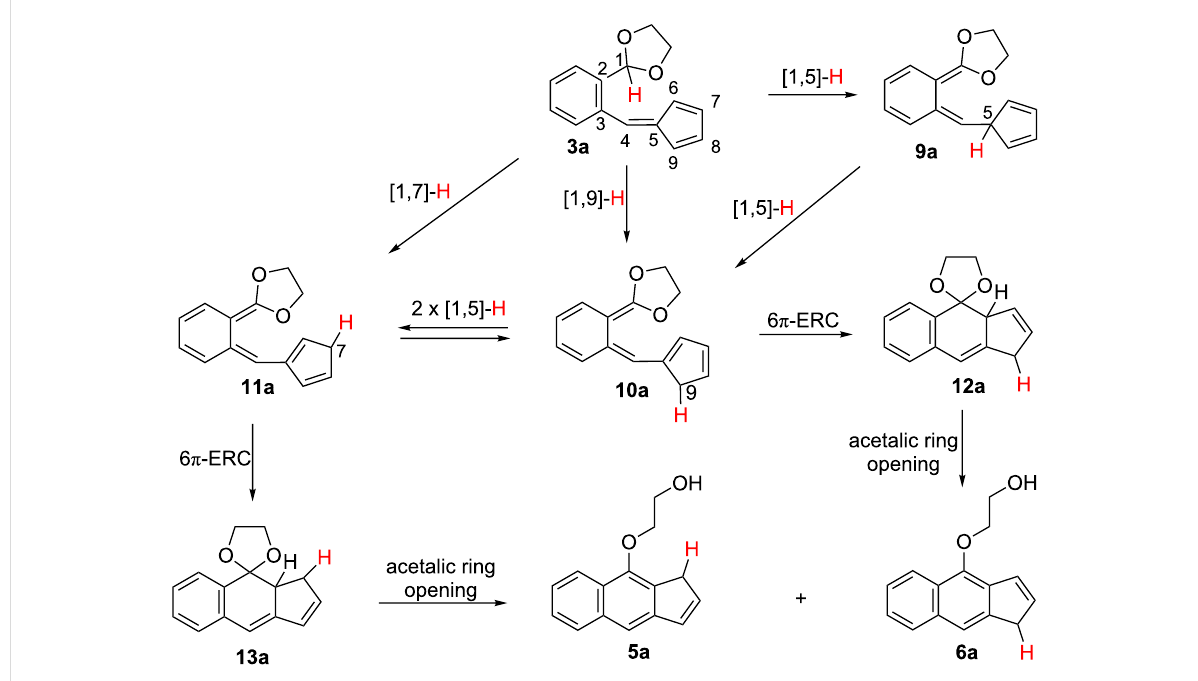
Scheme 4: Alternative mechanistic paths for the conversion 3a → 5a + 6a initiated by [1,5]-, [1,7]- or [1,9]-H